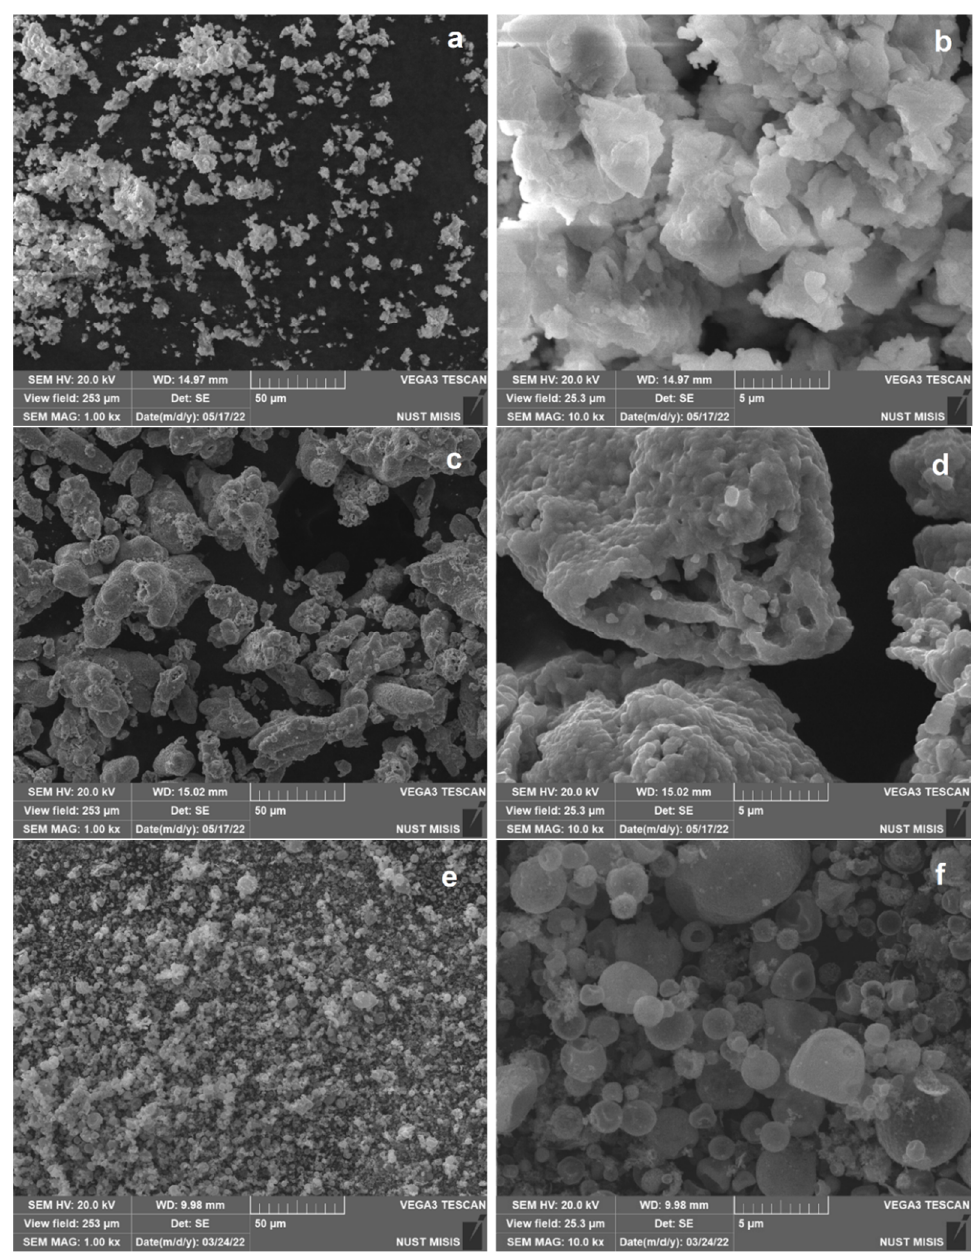
Figure 5. SEM micrographs of antimicrobial additive particles: CuSO 4 powder ( a , b ); CuO powder ( c , d ); CuO microspheres ( e , f ).